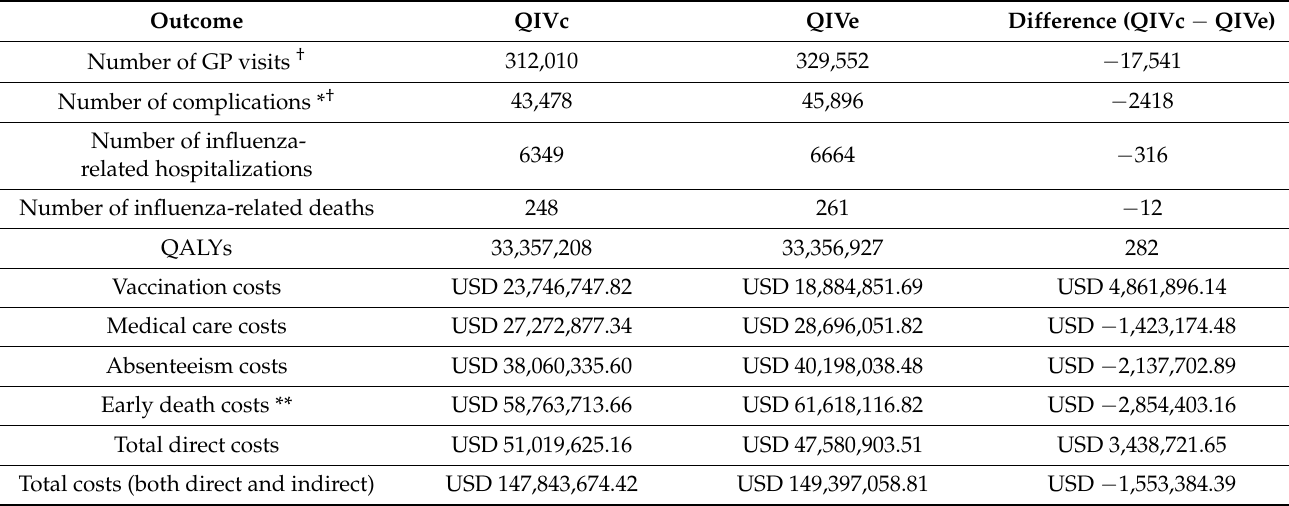
Table 3. Model results—base